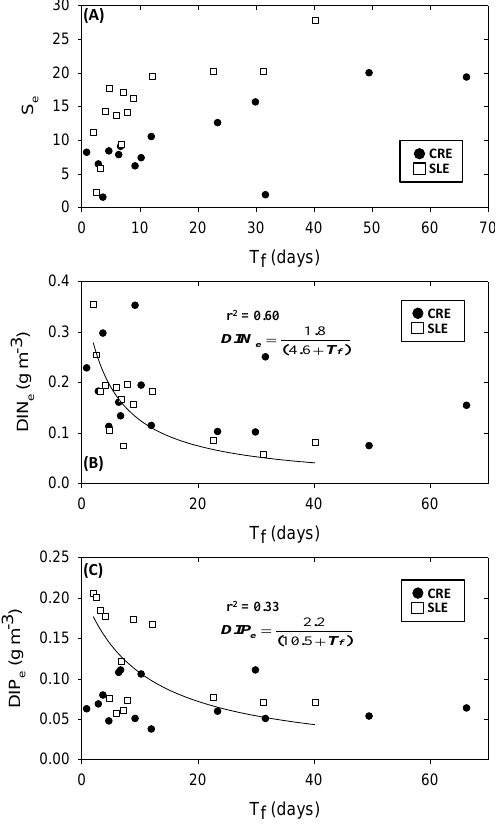
Fig. 5. Scatter plots from seasonal DIN and DIP budgets for CRE and SLE from 2002 to 2008. (A) Freshwater discharge ( V Q ) vs. estuary salinity; (B) external DIN load (g Nm − 2 d − 1 ) vs. estuary DIN concentration (g m − 3 ) ; (C) external DIP load (g Pm − 2 d − 1 ) vs. estuary DIP concentration (gm − 3 ) . Regression lines, r 2 values, and equations provided for the SLE points only.